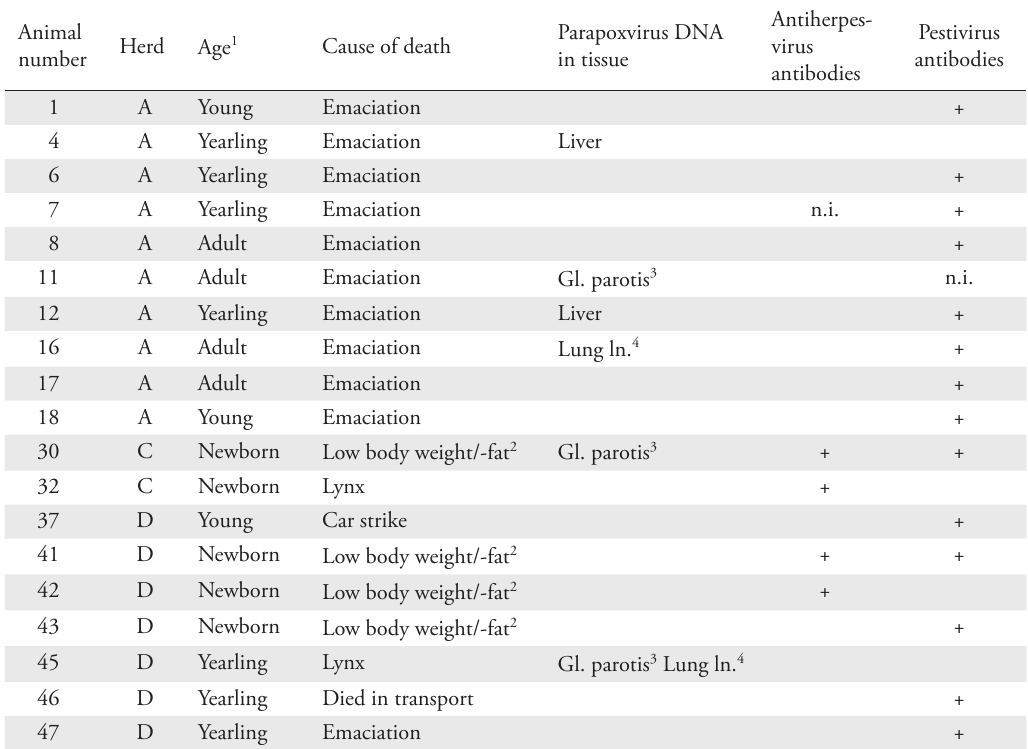
Table 2. Semi-domesticated reindeer from herds A (western Finnmark) and C and D (eastern Finnmark), Norway, with evidence of parapoxvirus (virus-specific DNA in tissue samples; PCR), alphaherpesvirus and pestivirus infection